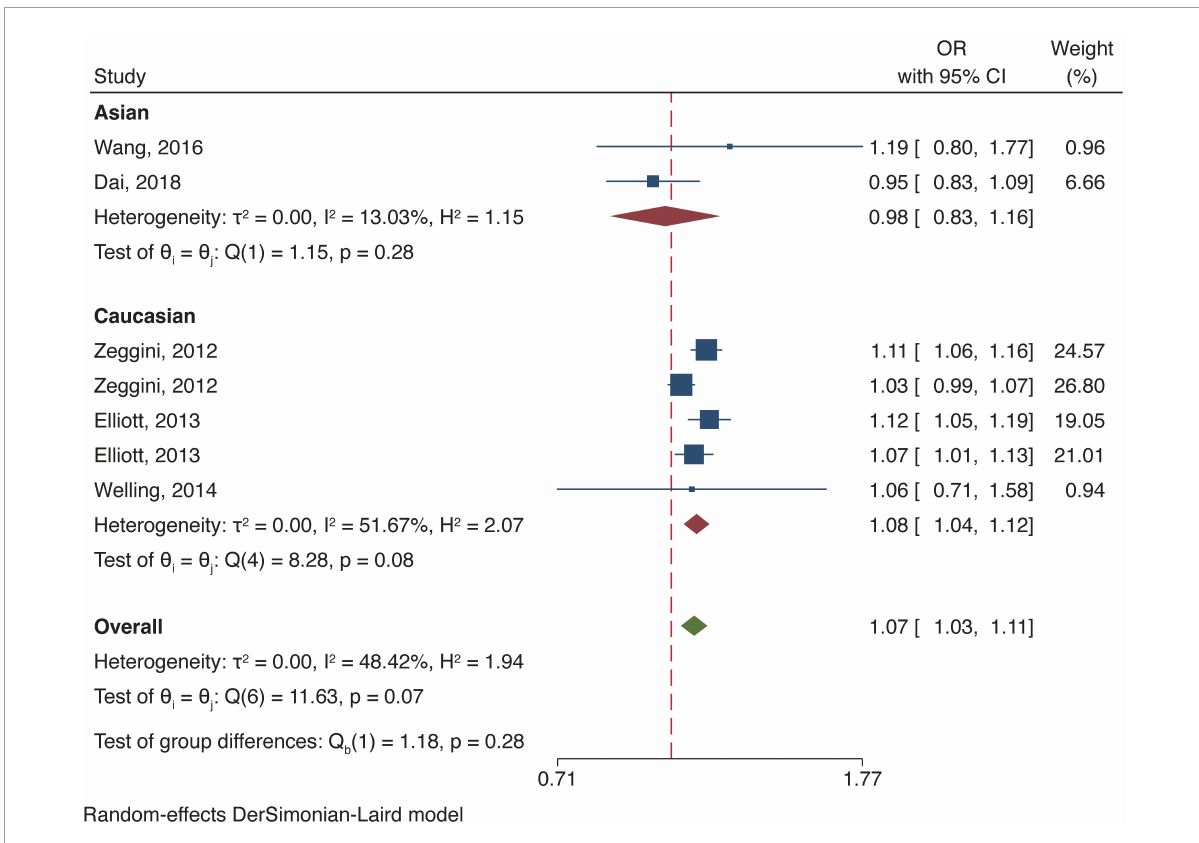
FIGURE3 Meta-analysis of FTO gene polymorphism and OA risk in all